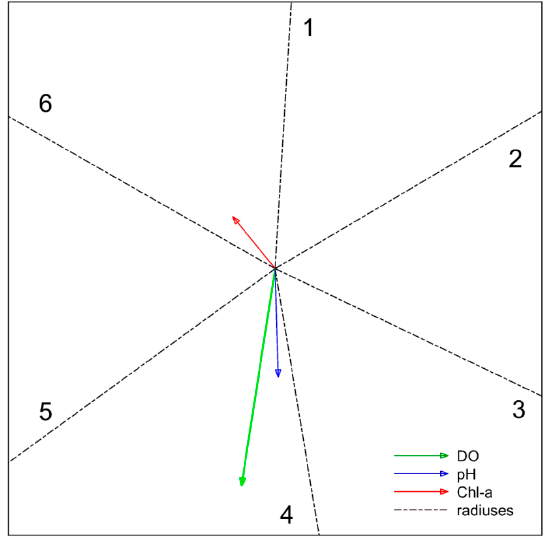
Figure 7. The final resultant vector gradients.